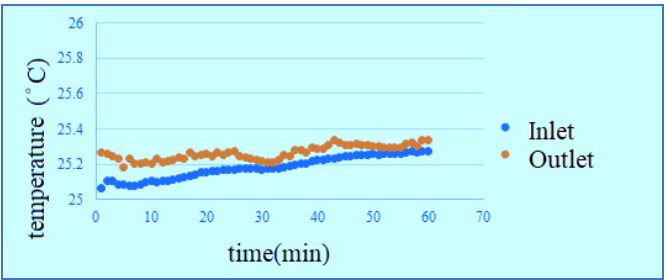
Figure 14. Low-temperature low-flow outlet/inlet temperature curve diagram.